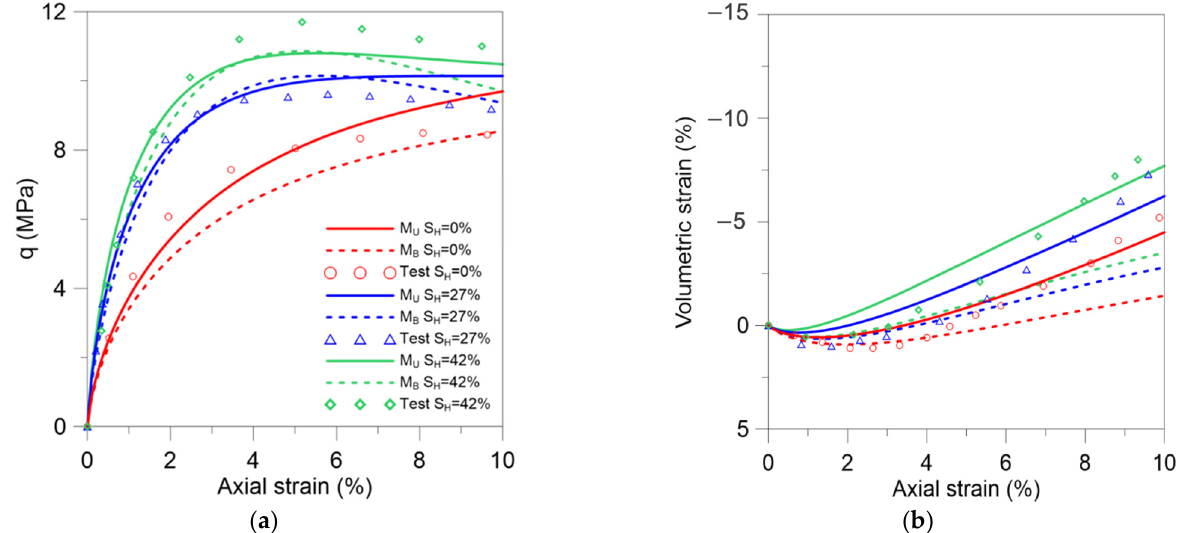
Figure 7. Modeling the tests reported in Miyazaki et al. [82] at σ 3 = 3 MPa. ( a ) deviatoric stress versus axial strains; ( b ) volumetric strains versus axial strains.